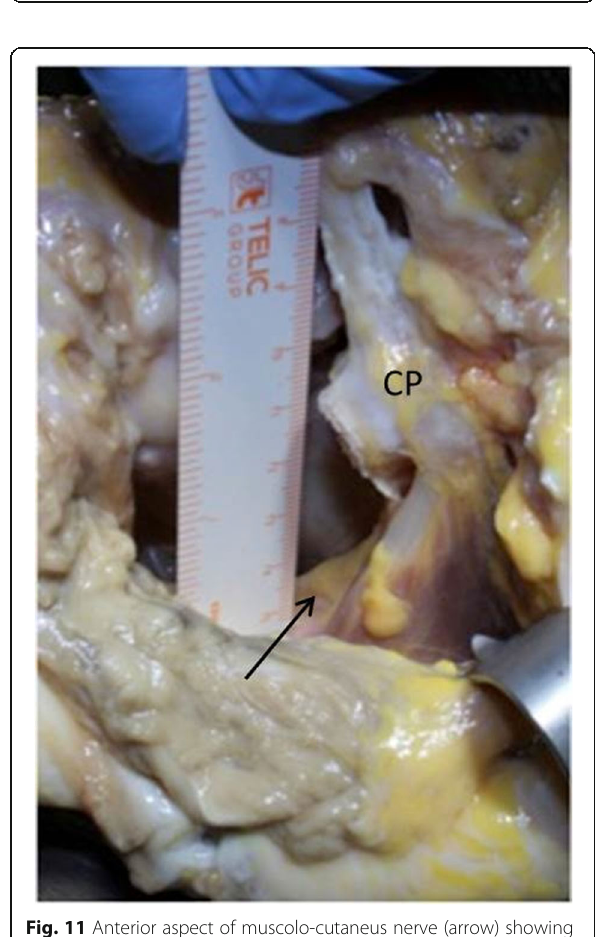
Fig. 11 Anterior aspect of muscolo-cutaneus nerve (arrow) showing the distance from the antero-inferior portal enlarged from seven mm to fiftheen (CP: coracoid